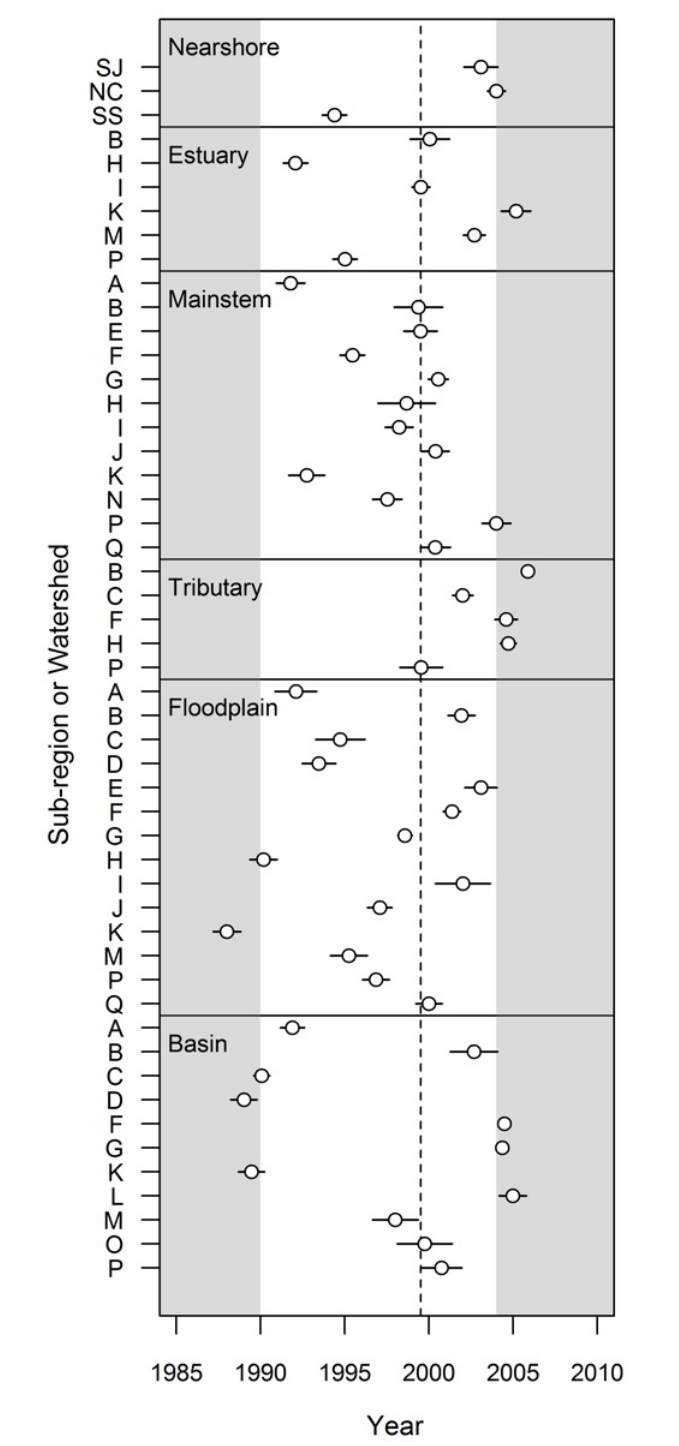
Fig 7. Breakpoint Estimates: Watershed Scale. Breakpoint estimates (open circles), standard errors (surrounding bars), and median value (dotted line) for six habitat areas, summarized at the watershed scale. Only those watersheds in which the segmented regression outperformed the simple regression (i.e., Δ AICc > 4) are shown. Breakpoints within the tail ends of the time series (gray shaded areas) should be viewed with